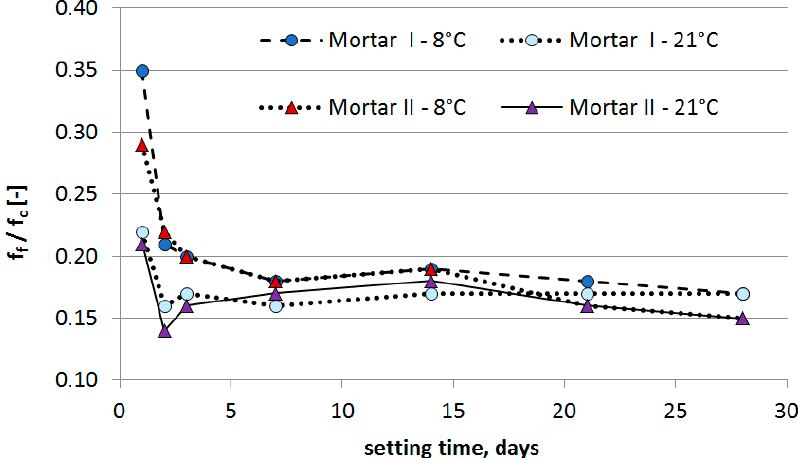
Figure 11. Quotient of the values of flexural and compressive strength for subsequent days of repair mortar setting at 21 °C and 8 °C, respectively.